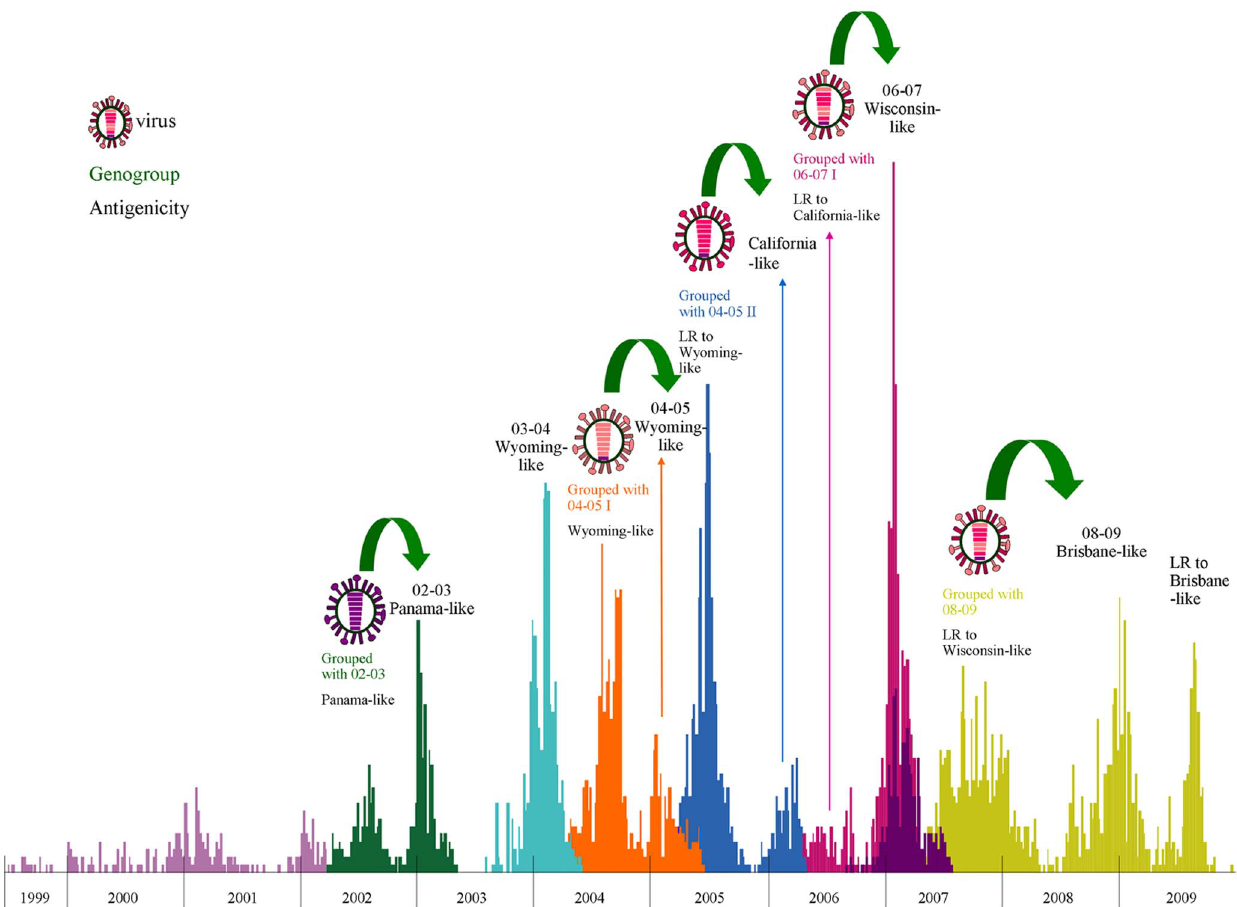
Figure 3. Dynamics of genetic and antigenic properties of influenza A (H3N2) virus during 1999–2009 in Taiwan. The influenza A viruses undergo the multiple reassortment involving all eight segments of the viral genome. Colored rectangles represent the genetic relationship and antigenicity for viruses isolated in summer, which is a non-epidemic period. This representation shows that the majority of the strains emerging in summer were closely related to (both genetically and antigenically), and were more likely to be the progenitor of the subsequent winter epidemic strains of that subtype. Histograms represent the incidence of flu in Taiwan during the past epidemics; color schemes are same as in Figure 1C.